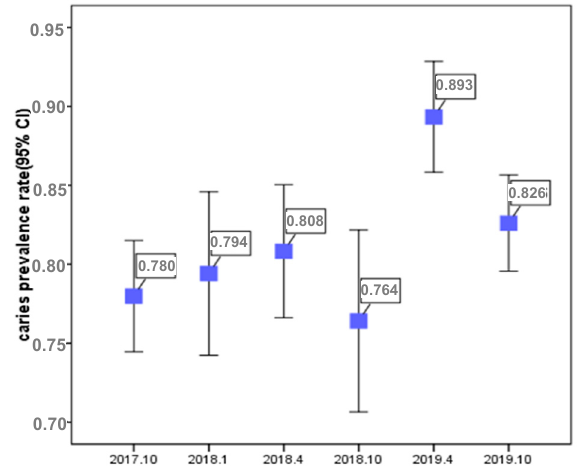
Figure 3. Caries prevalence rate.